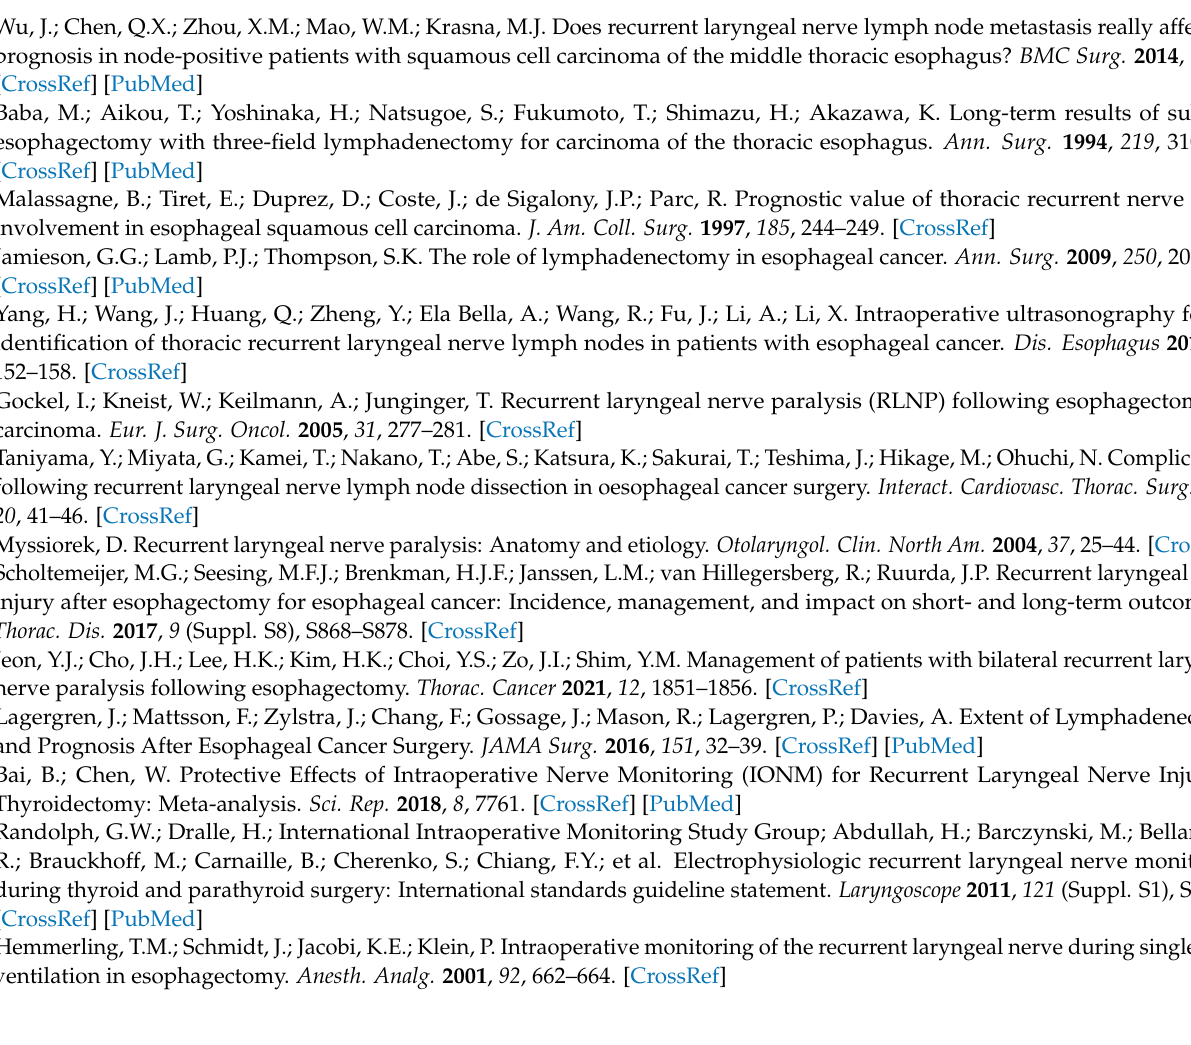
Supplementary Table S5: Sensitivity Analysis of IONM for Pneumonia. Supplementary Table S6: Sensitivity Analysis of IONM for Chylothorax. Supplementary Table S7: Sensitivity Analysis of IONM for Anastomotic Leakage. Supplementary Table S8: Sensitivity Analysis of IONM for Total LN Dissected. Supplementary Table S9: Sensitivity Analysis of IONM for POHS. Supplementary Table S10: Sensitivity Analysis of IONM for Total Operation